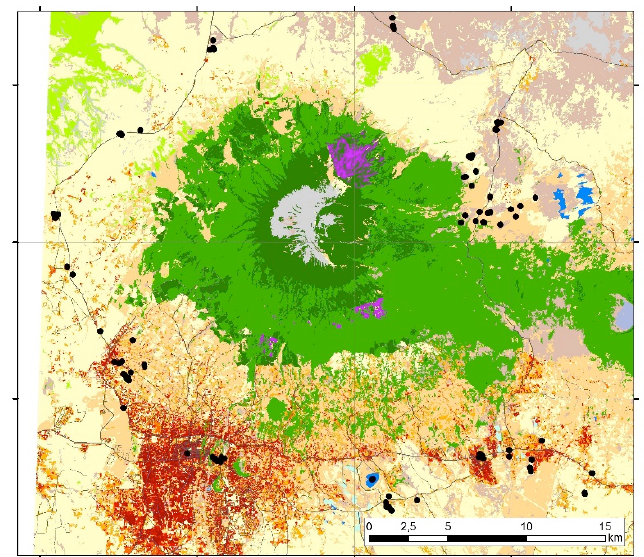
Figure 5. Position of observation points collected in Tanzania study area.